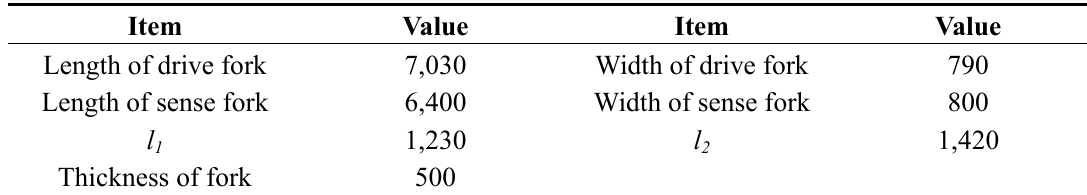
Table 1. The dimensions of the chip ( μ m).